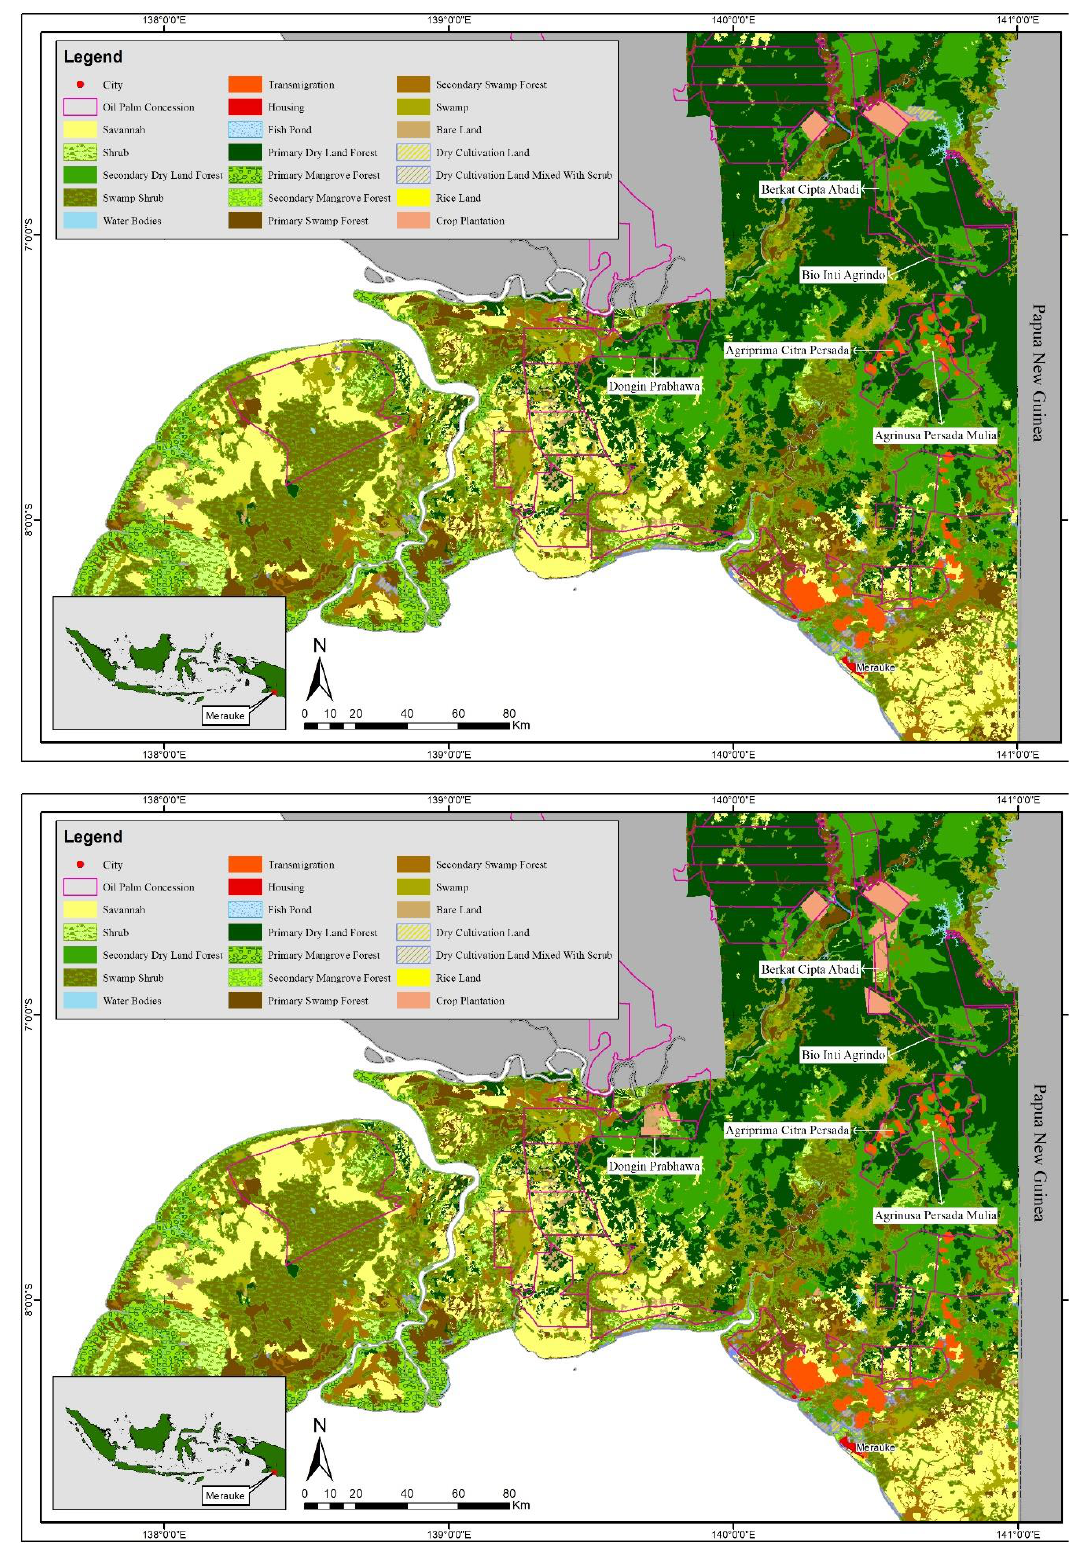
Figure 1. Southern Papua land cover series map year 2008 (above) and year 2013 (below). The companies were granted dry lands originating from primary forests and savanna where they grow oil palm [2,24]. Growing palm oil crops on such dry land is easier and less costly than